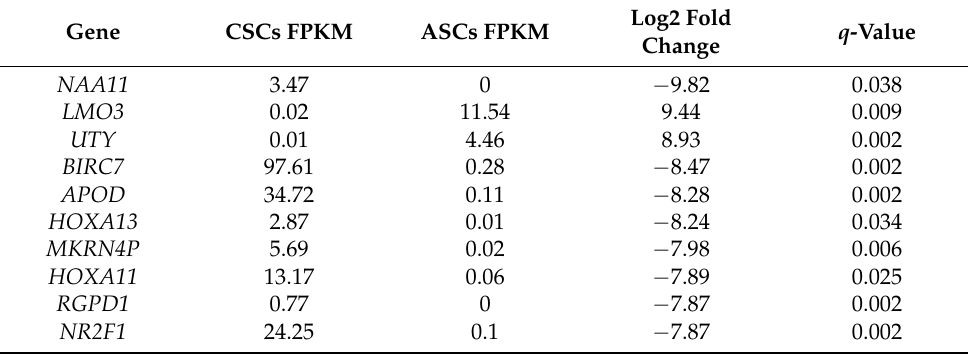
Table 1. Top 10 most significantly differentially expressed genes.